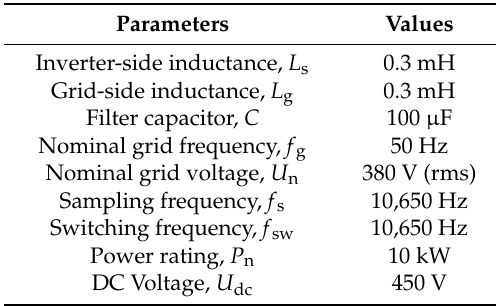
Table 1. Power circuit parameters of the grid-connected inverter.